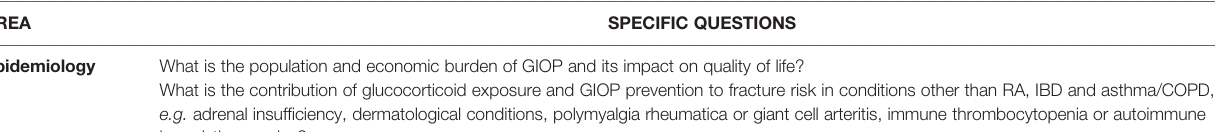
TABLE 6 | The research agenda: key areas in the clinical management of GIOP requiring further research.